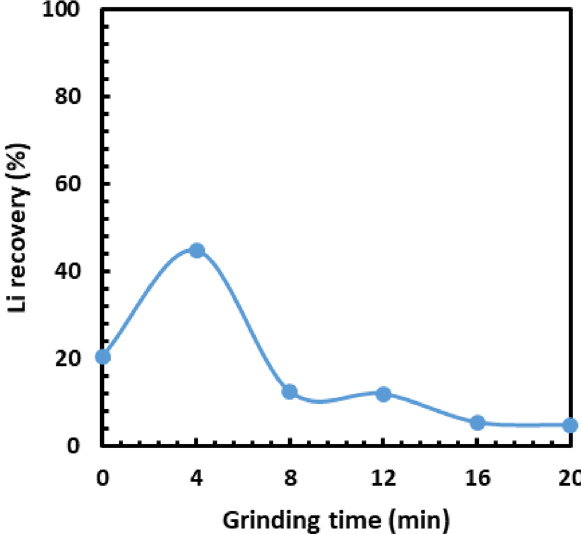
Figure 6. Effect of grinding time and screening on the lithium recovery in the finest size fractions (− 0.6 mm).